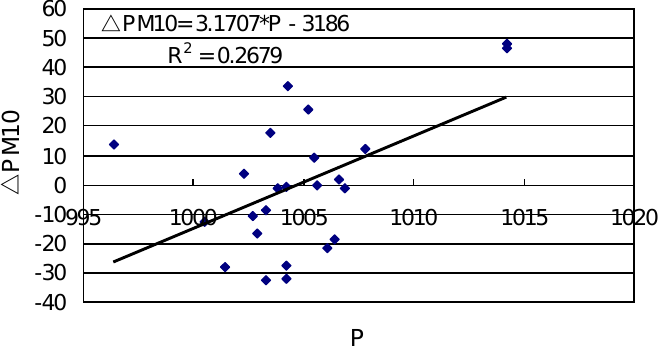
estimates predicted from AOT against pressure 10 △ PM10= 3.1707*P - 3186 R 2 = 0.2679